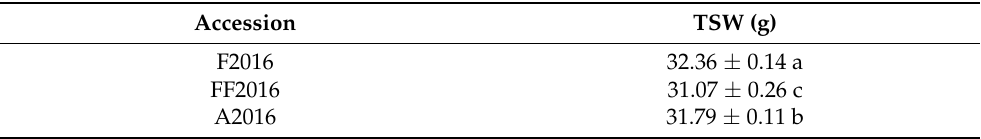
Table 1. Determination of the thousand seed weight (TSW) for each investigated accession of P. incarnata (F2016, FF2016, and A2016).